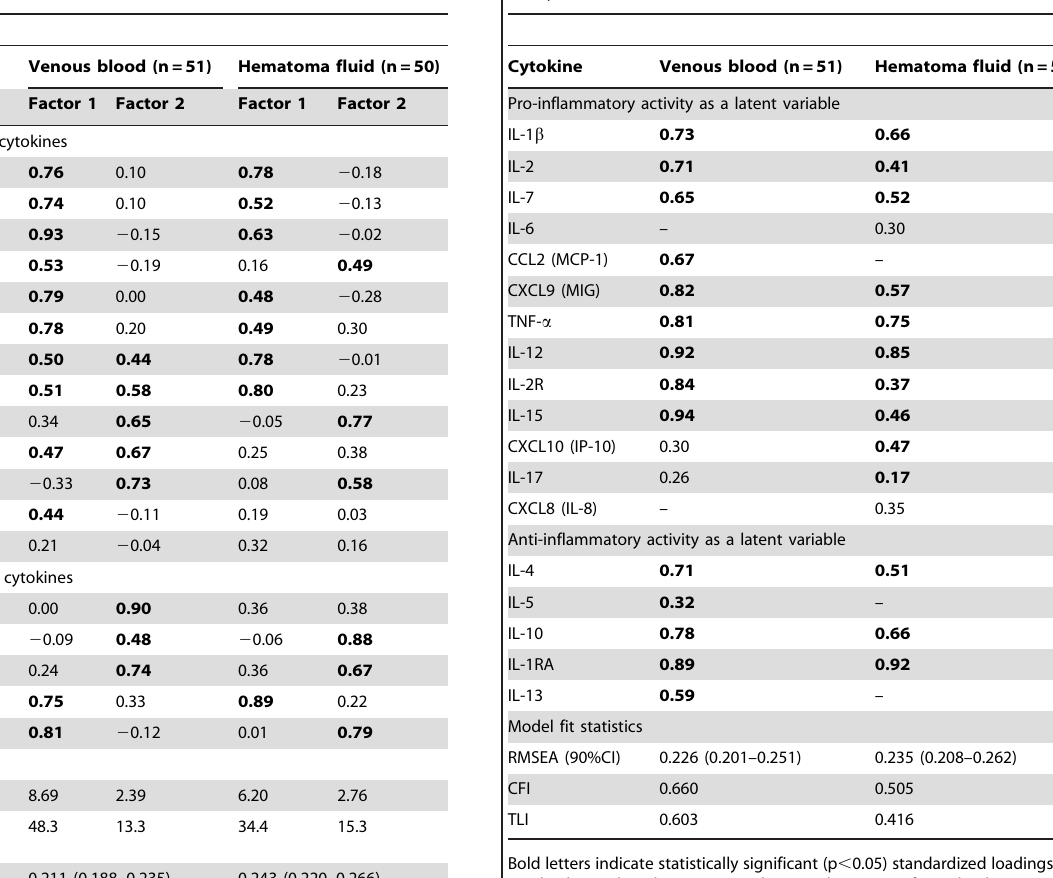
Table 3. Standardized loadings from confirmatory factor analysis.